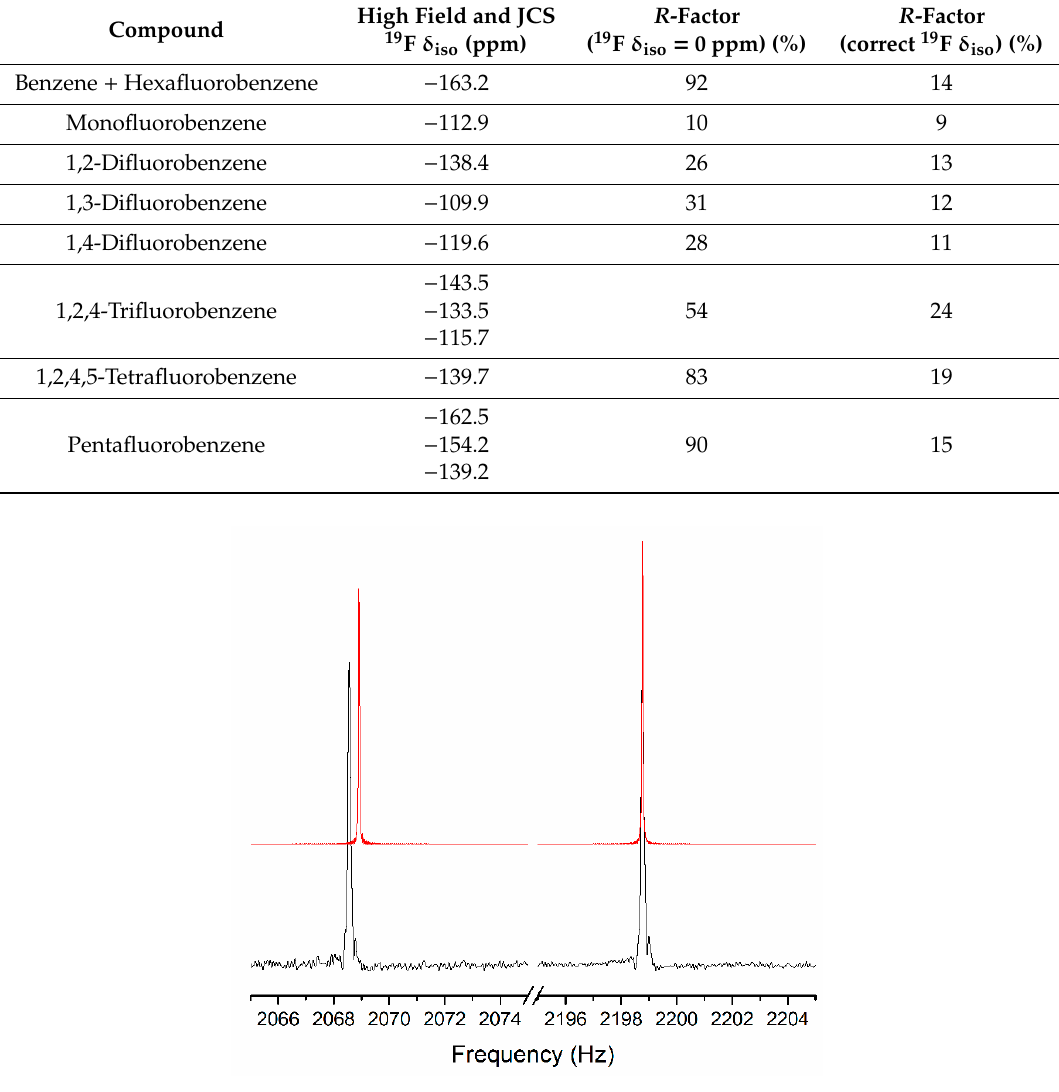
Table 3. Comparison of R -factors for simulation of the JCS accounting for chemical shift.